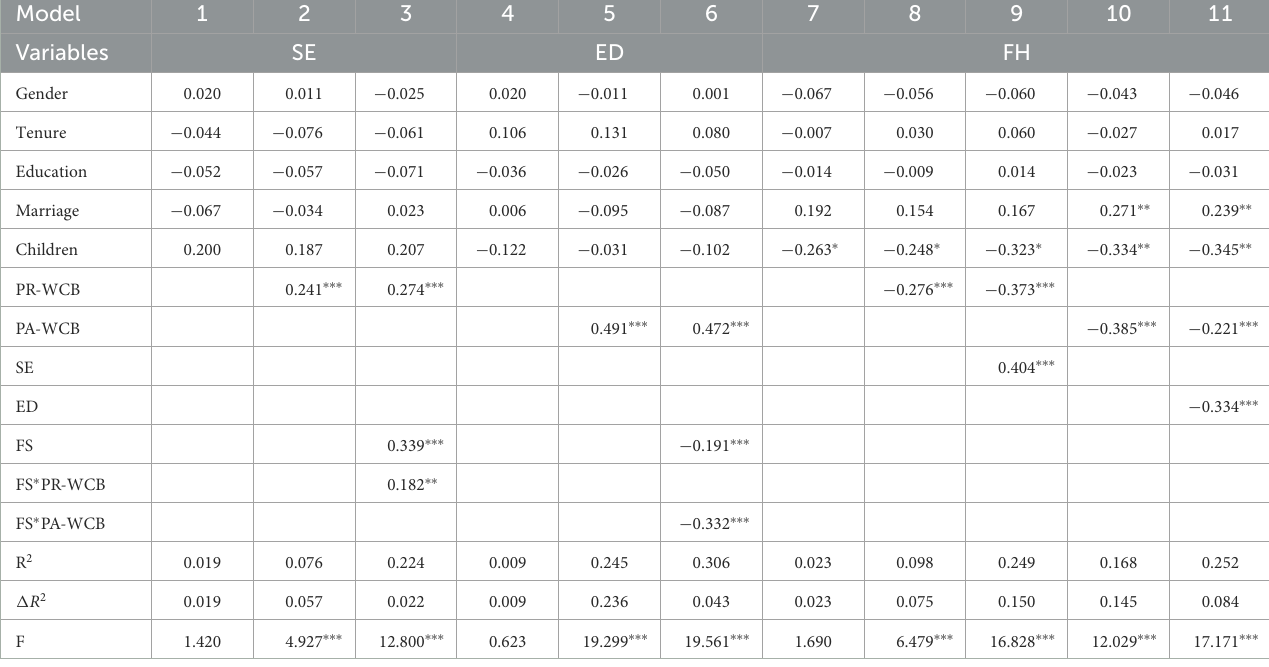
TABLE 5 Results for regression